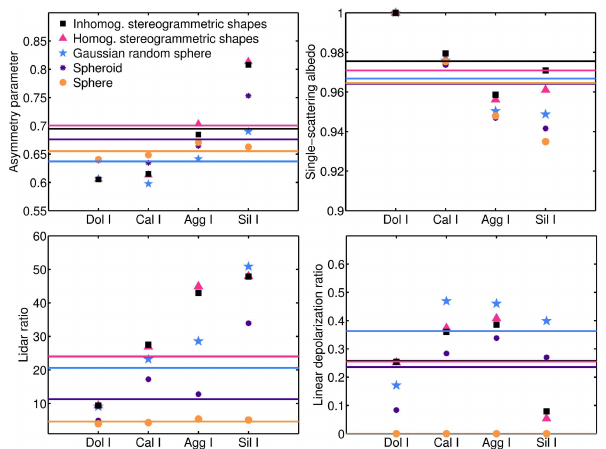
Fig. 11. Comparison of scattering properties of the inhomoge- neous stereogrammetric shapes and simplified models: homoge- neous stereogrammetric shapes, spheres, spheroids, and Gaussian random spheres. Scattering has been integrated over a log-normal size distribution with size parameters from x = 0 . 5 to x = 16. Solid lines correspond to the integrated results over the four particles. The top-panel parameters are important in radiation computations and climate considerations, and the bottom-panel parameters are needed in remote-sensing applications using a depolarization